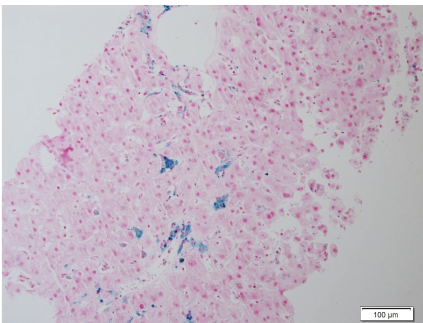
Figure 1: Liver biopsy 6 months after OLT showing hyper- trophic macrophages containing iron and slight accumulation of hemosiderin in hepatocytes (Perls’ stain).